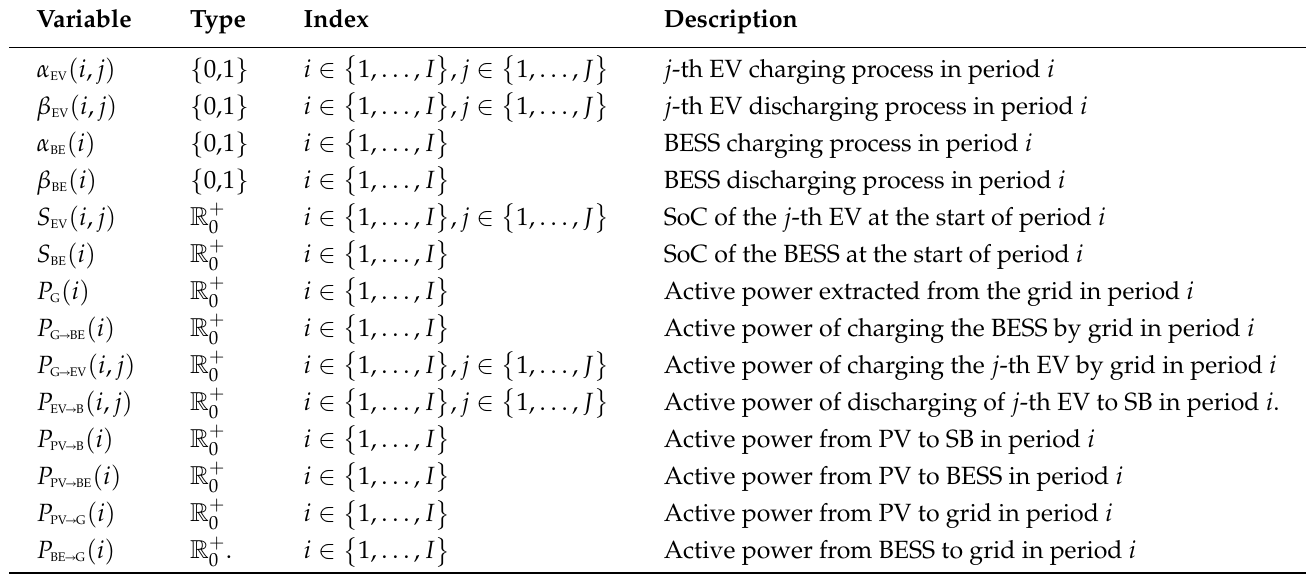
Table 2. Decision variables of the